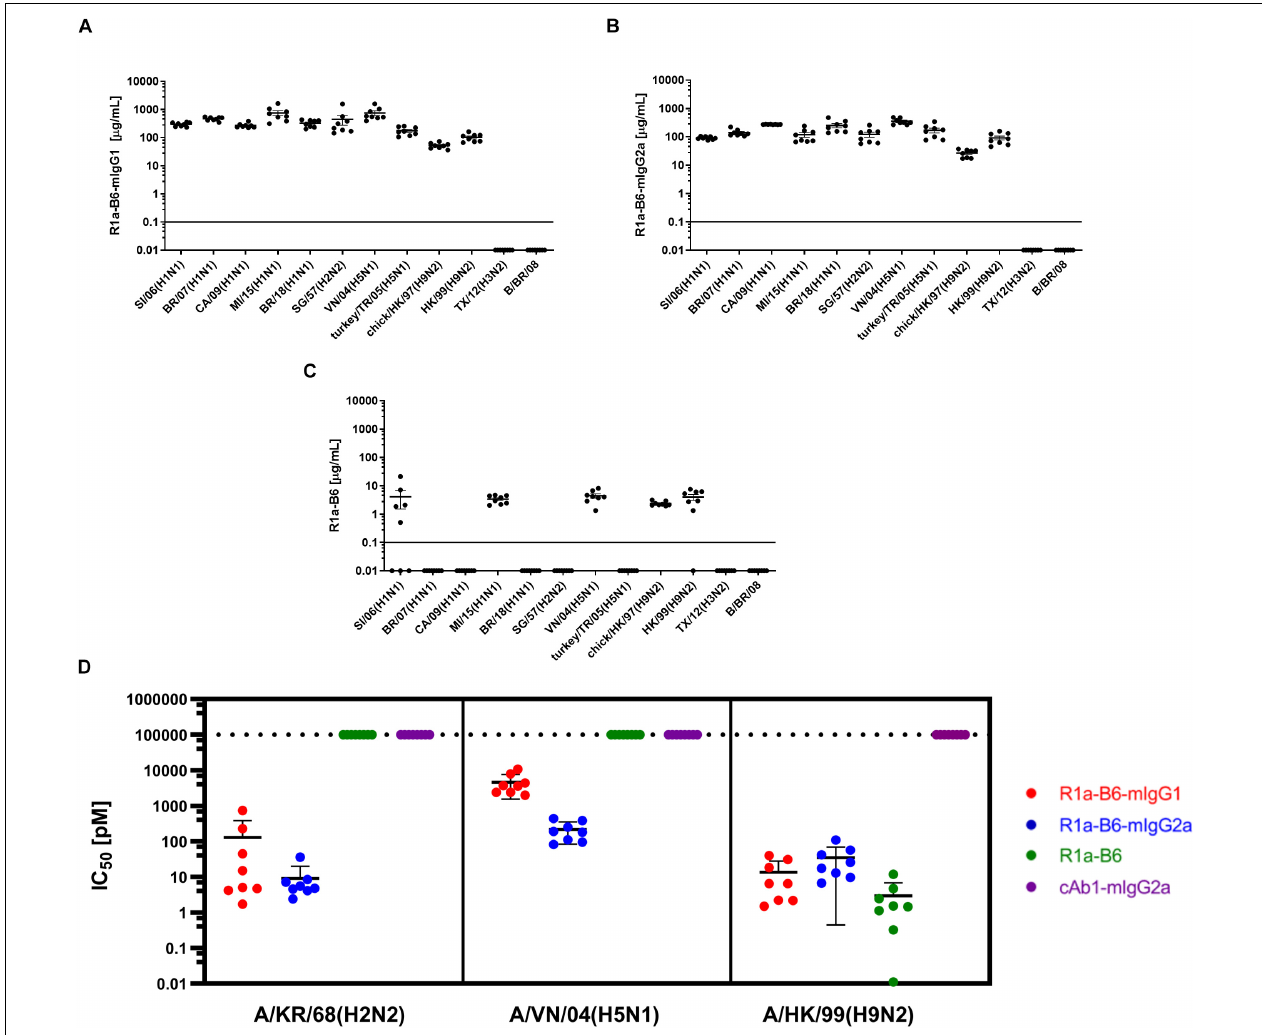
FIGURE 3 | Evaluation of heterosubtypic R1a-B6 reactivity in mouse sera 39 days after IM injection of 1.0 × 10 11 vg AAV encoding nanobodies. (A–C) Binding of R1a-B6 against different influenza subtypes was tested via ELISA. Plates were coated with 5 µ g/mL influenza reference reagent ( Supplementary Table 3 ) and the Absorbance at 450 nm was plotted against a serial dilution of recombinant nanobody for standard curve analysis. Recombinant nanobody concentration in serum corresponding to the sample binding activity was plotted. Samples were measured in duplicate. All values below the solid line represent no detectable binding activity. A/Texas/50/2012(H3N2) (TX/12) and B/Brisbane/60/2008 (B/BR/08) served as negative controls. (D) In vitro neutralization against different influenza pseudotypes was determined via a luciferase-reporter assay and given as IC 50 values (IC 50 is half maximal inhibitory concentration). All values above the dotted line indicate no neutralization. For all plots, n = 8